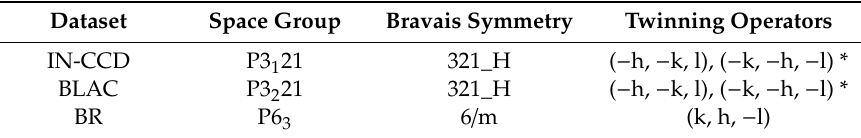
Table 2. Symmetry information of the test datasets.